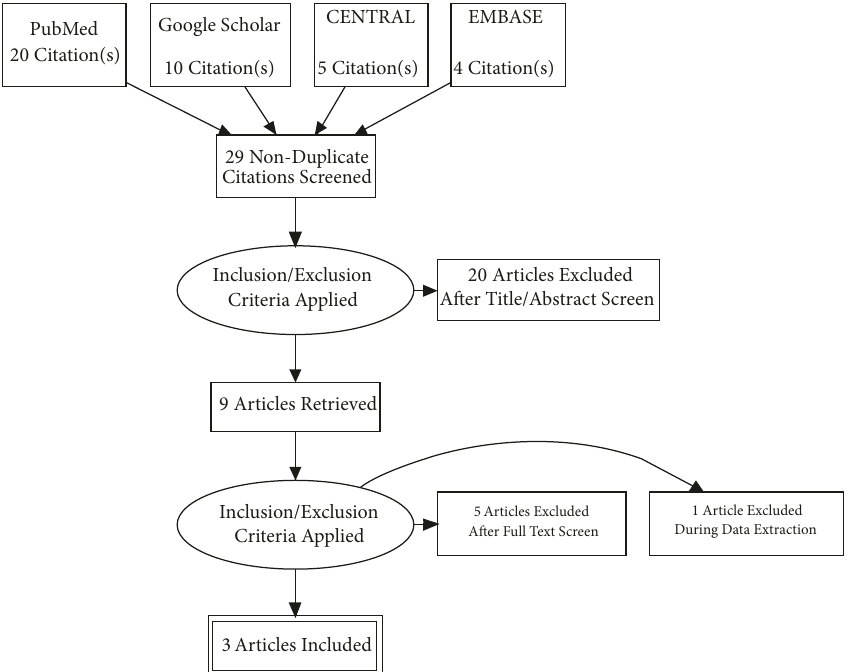
Figure 1: PRISMA diagram detailing the study identification and selection